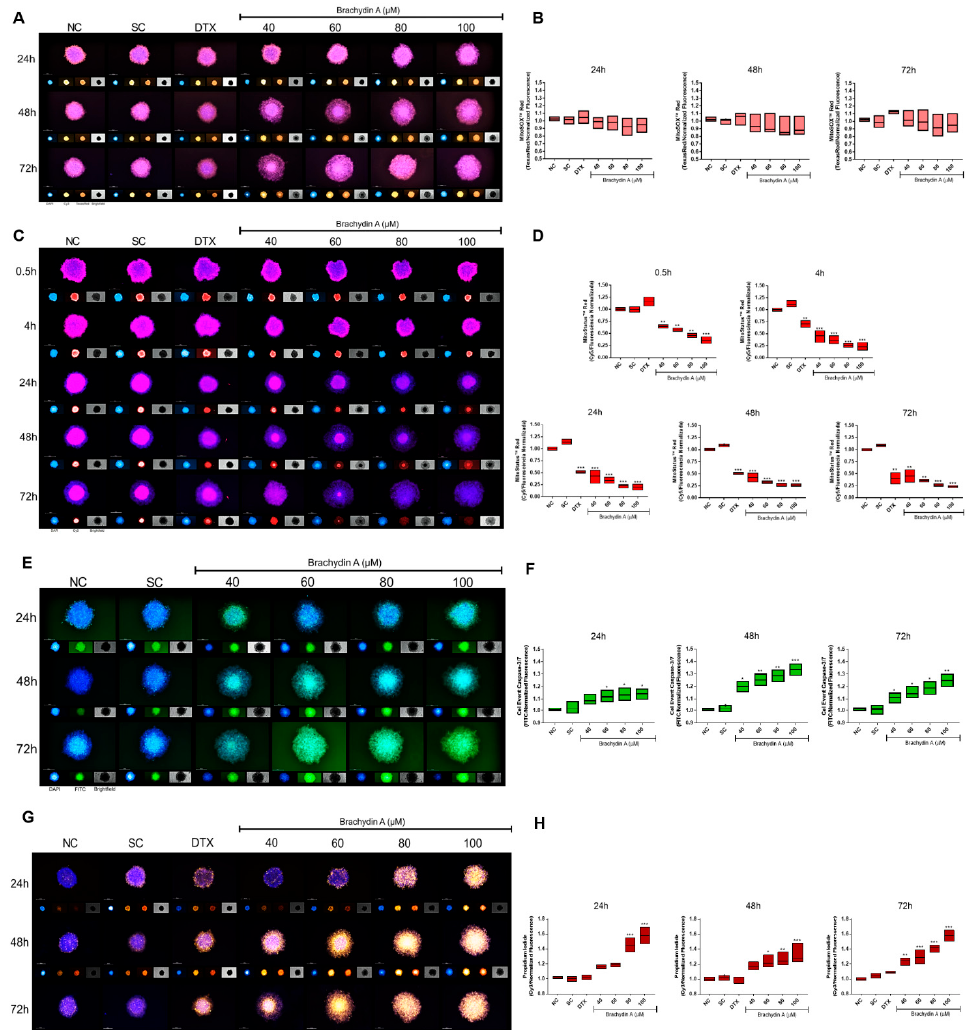
Figure 6. ( A , C , E , G ) Representative images of the effects of Brachydin A (BrA) and controls on mitochondrial ROS (MitoSOX Red), mitochondrial membrane potential (MitoStatus), apoptosis (Caspase 3/7), and necrosis (PI) in DU145 spheroids, respectively. The photomicrographs were acquired using the In-Cell Analyzer 2200 platform, using a 4× objective, in DAPI (Hoechst 33342), Cy5 (MitoStatus), FITC (CellEvent Caspase 3/7), and Cy3 (PI) channels. Scale: 200 μ m. ( B , D , F , H ) Fluorescence intensity for MitoSOX Red (TexasRed), MitoStatus Red (Cy5), Caspase 3/7 (FITC), and PI (Cy3) in DU145 spheroids after treatment with BrA and respective controls. Data were normalized to the mean fluorescence intensity of the NC group at each time/point. The bars represent the mean ± standard deviation of four ( n = 4) spheroids/replicates from three biological experiments ( n = 3). * Values statistically different from the NC group (* p < 0.05; ** p < 0.01; *** p < 0.001; ANOVA followed by Dunnett’s post-test). NC: negative control (RPMI 1640); SC: solvent control (1% DMSO); DTX: Docetaxel (50 μ M; positive control).